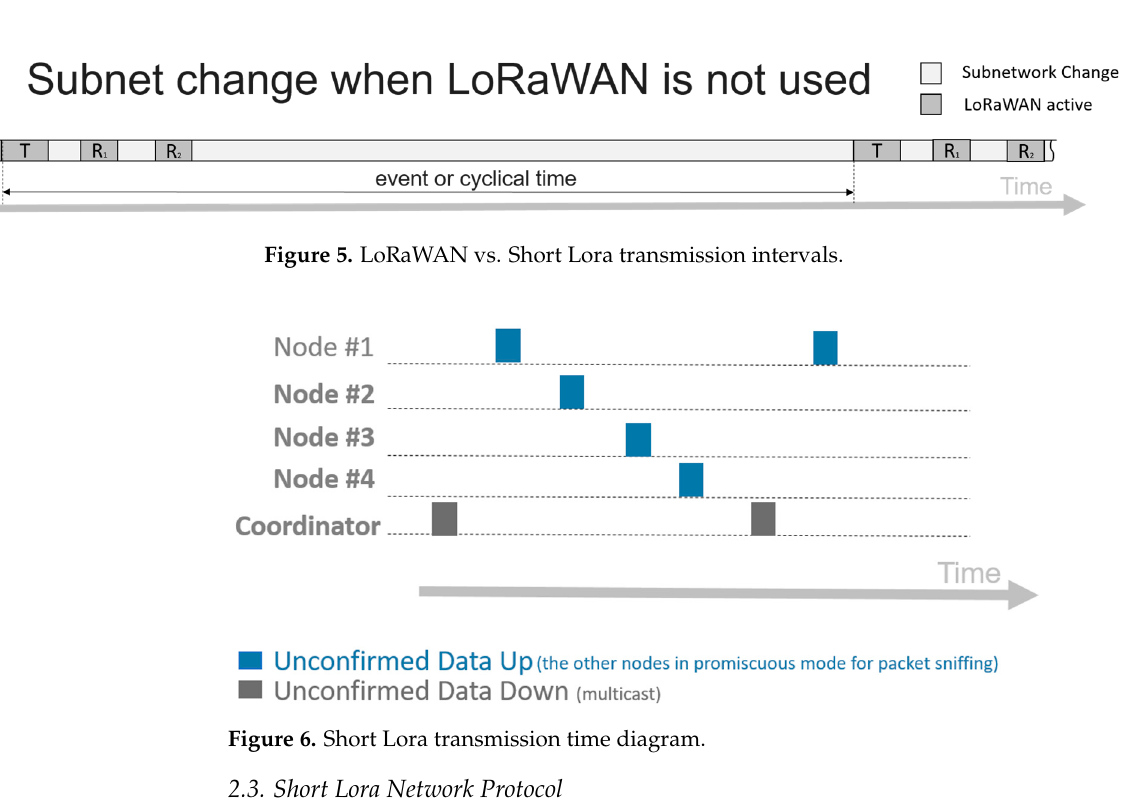
Figure 6. Short Lora transmission time diagram.